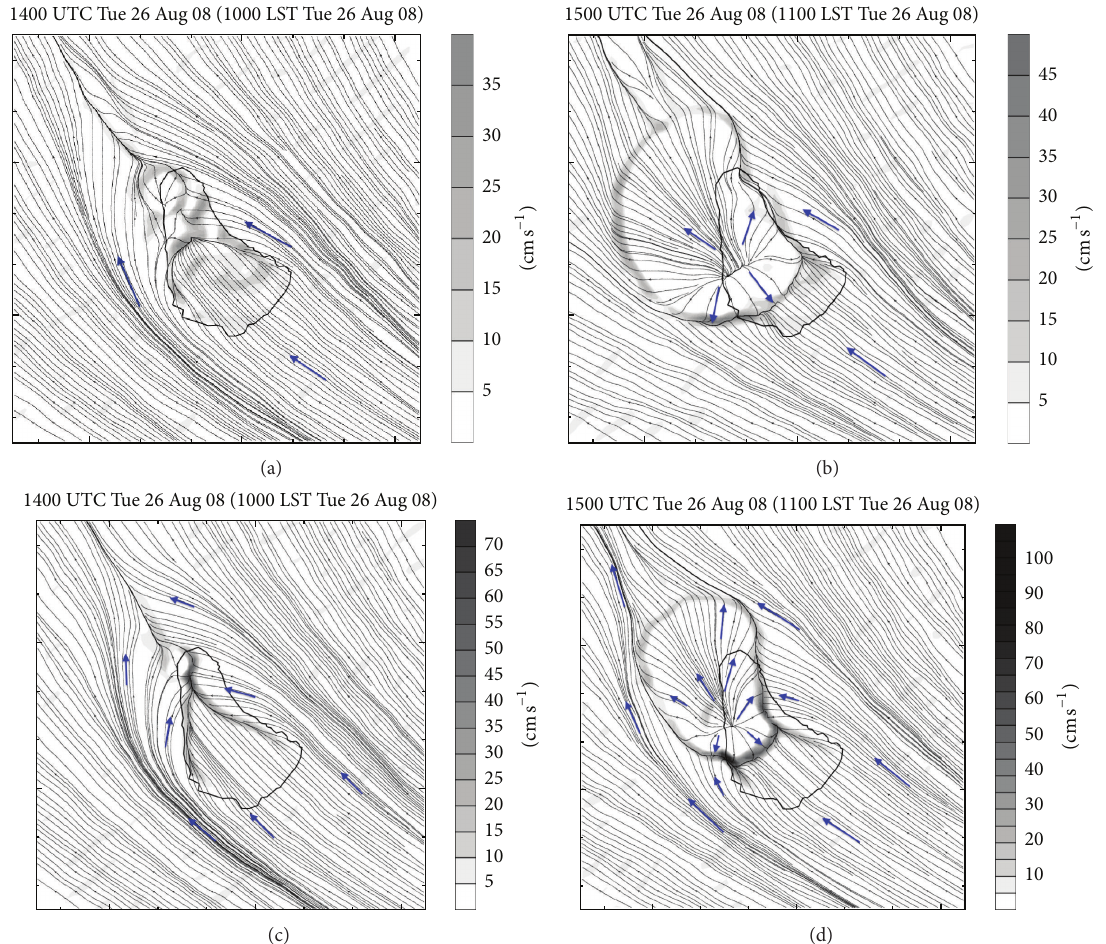
Figure 4: Streamline at 10m and vertical velocity at 900 hPa (shaded) for the CTRL experiment at (a) 1400UTC and (b) 1500 UTC. (c) and (d) are at the same time as (a) and (b) but for the NOTER experiment. The blue arrows indicate the general direction of the streamlines.